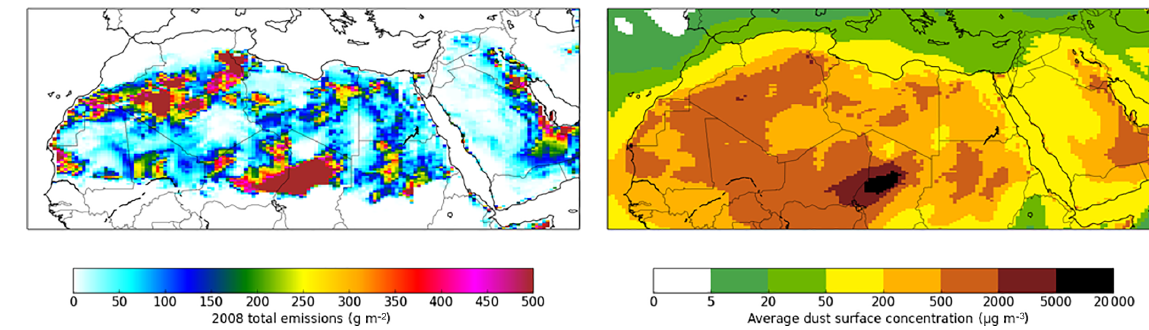
Figure 9. Annual total dust emissions and annual-average dust concentration for